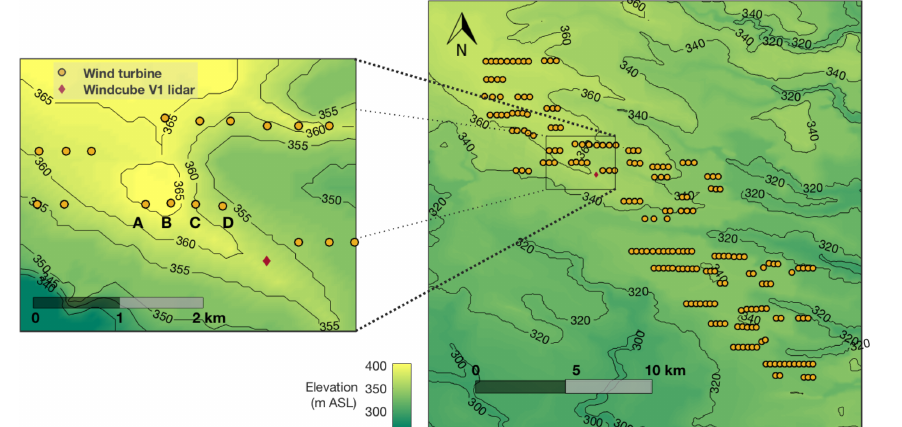
Figure 1. Schematic view of the wind farm in central Iowa where the CWEX-13 campaign took place. The turbines of interest for this study are marked as A–D.